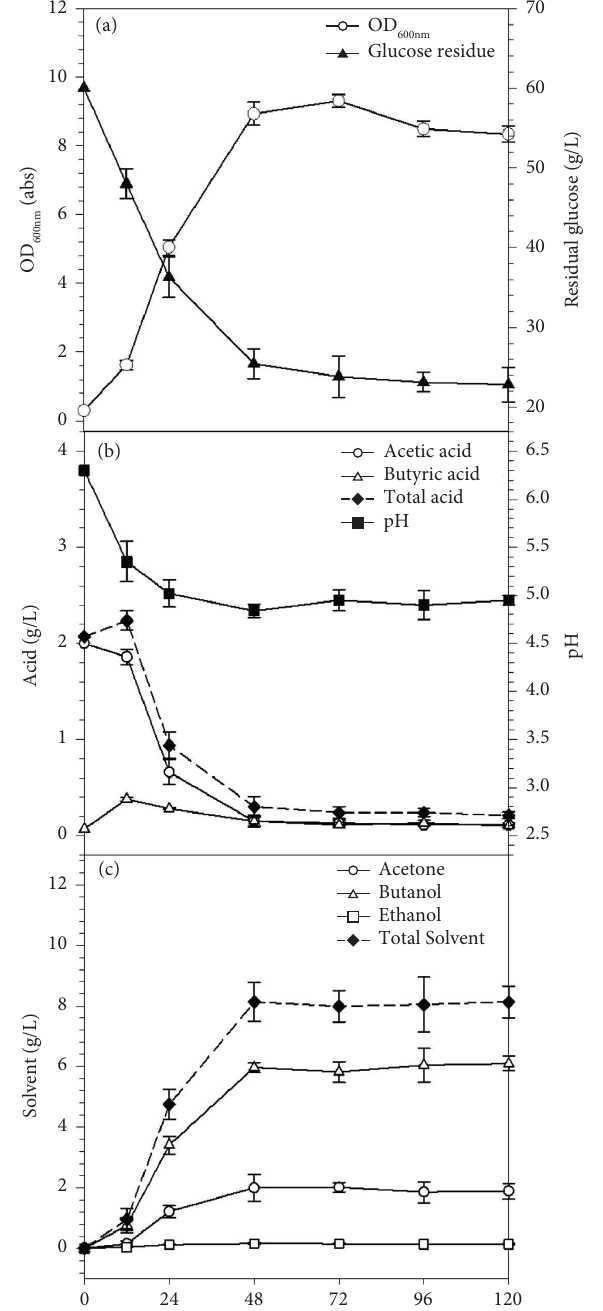
Figure 5: Te ABE fermentation by C. beijerinckii TISTR1461 free cell culture showing the levels of the (a) cell biomass and residual glucose, (b) pH, acetic, butyric, and total acids, and (c) acetone, butanol, and ethanol. Data are shown as the mean ± SD, derived from three replicated independent